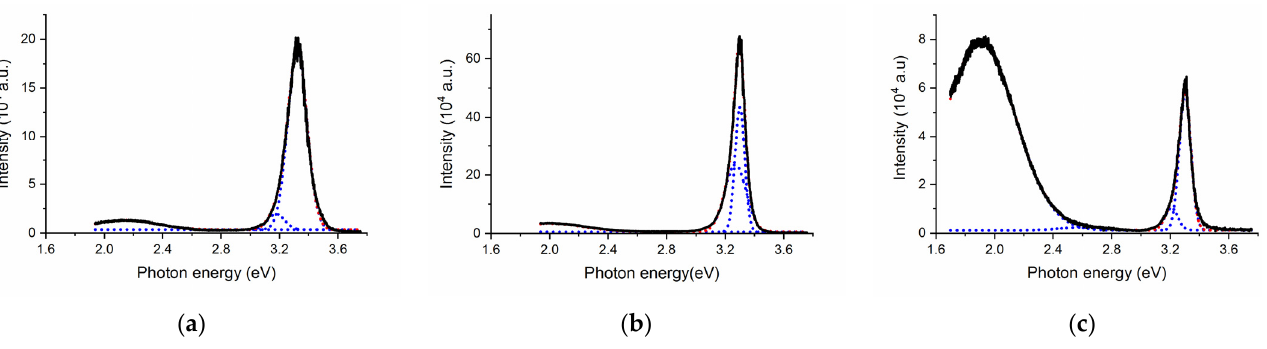
Figure 3. Fitting of PL spectra with multi-peak Gaussian function ( a ) as grown nanorods and nanorods ( b ) annealed at 350 °C ( c ) annealed at 600 °C. The solid lines are the experimental results. The dotted blue lines represent the Gaussian fitting of the different transition emission and the red line their sum.